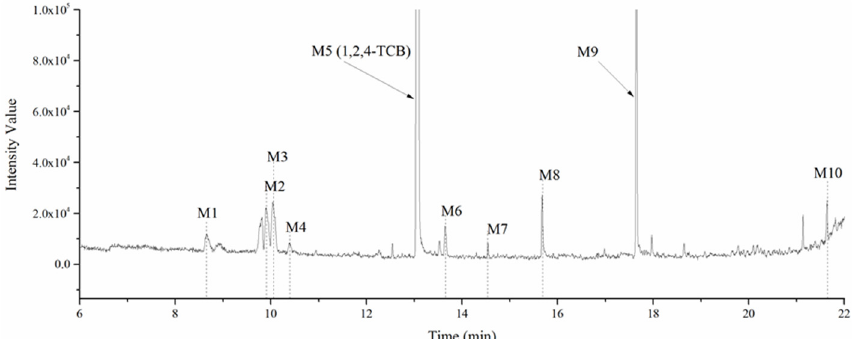
Figure 7. Chromatography of intermediate products of 1,2,4-TrCB degradation. The numbers M1 to M11 are the intermediate products corresponding to Table 1 .